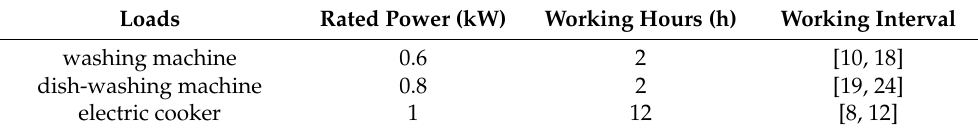
Table 2. Parameters of shiftable undisturbed loads.